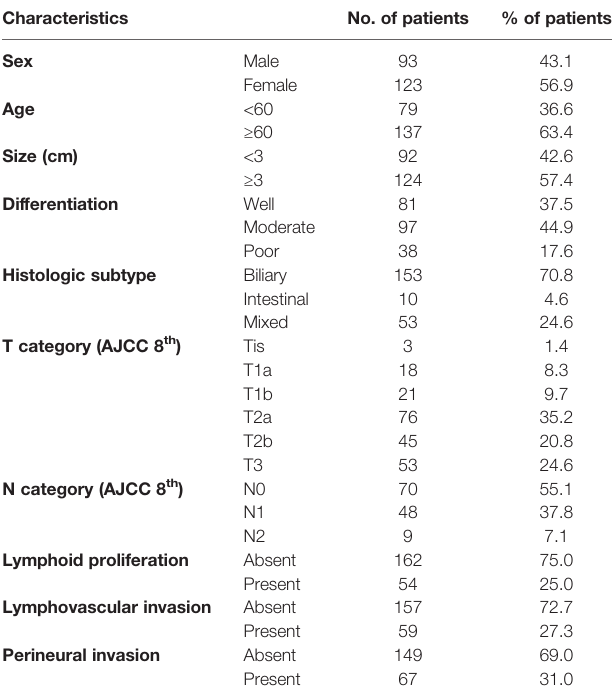
TABLE 1 | Clinicopathologic characteristics of the selected cases. Characteristics